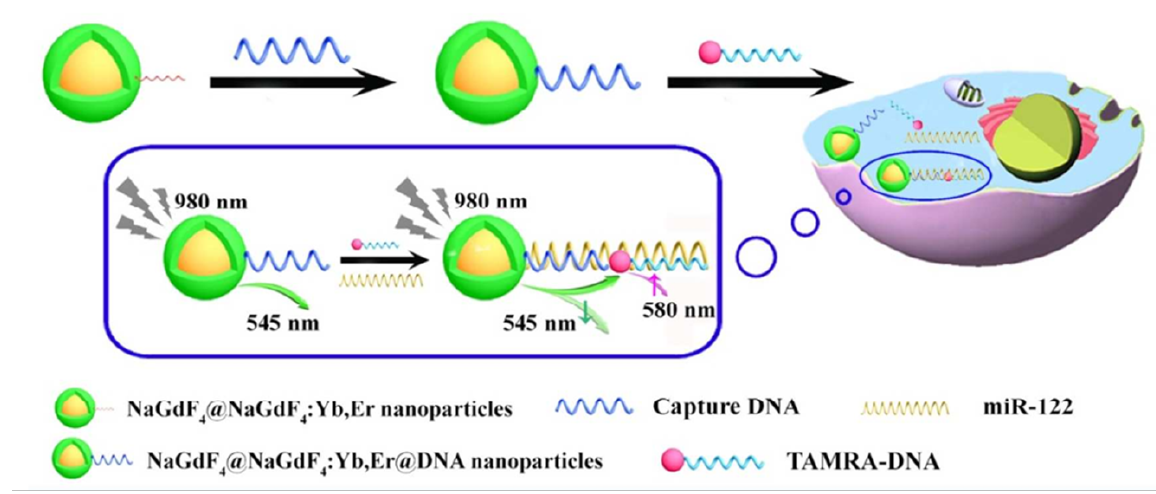
Figure 11: Schematic illustration of the synthesis and workflow of NaGdF 4 @NaGdF 4 :Yb,Er@DNA nanoparticles for sensitive detection of miR-122